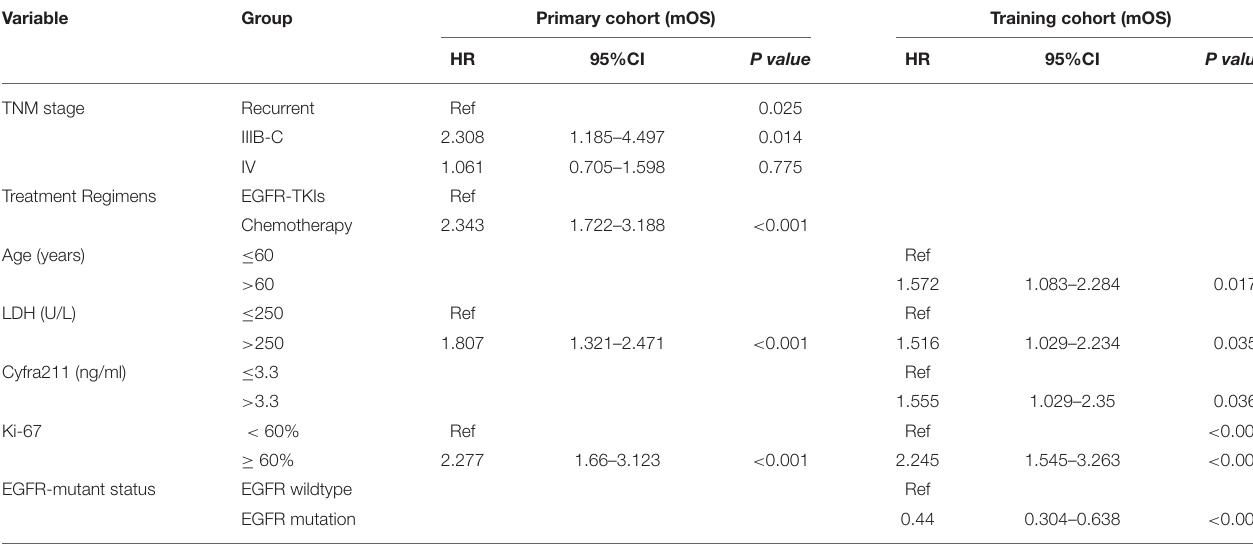
TABLE 3 | Multivariate analysis of independent risk factors for first-line therapy in training cohort. Variable